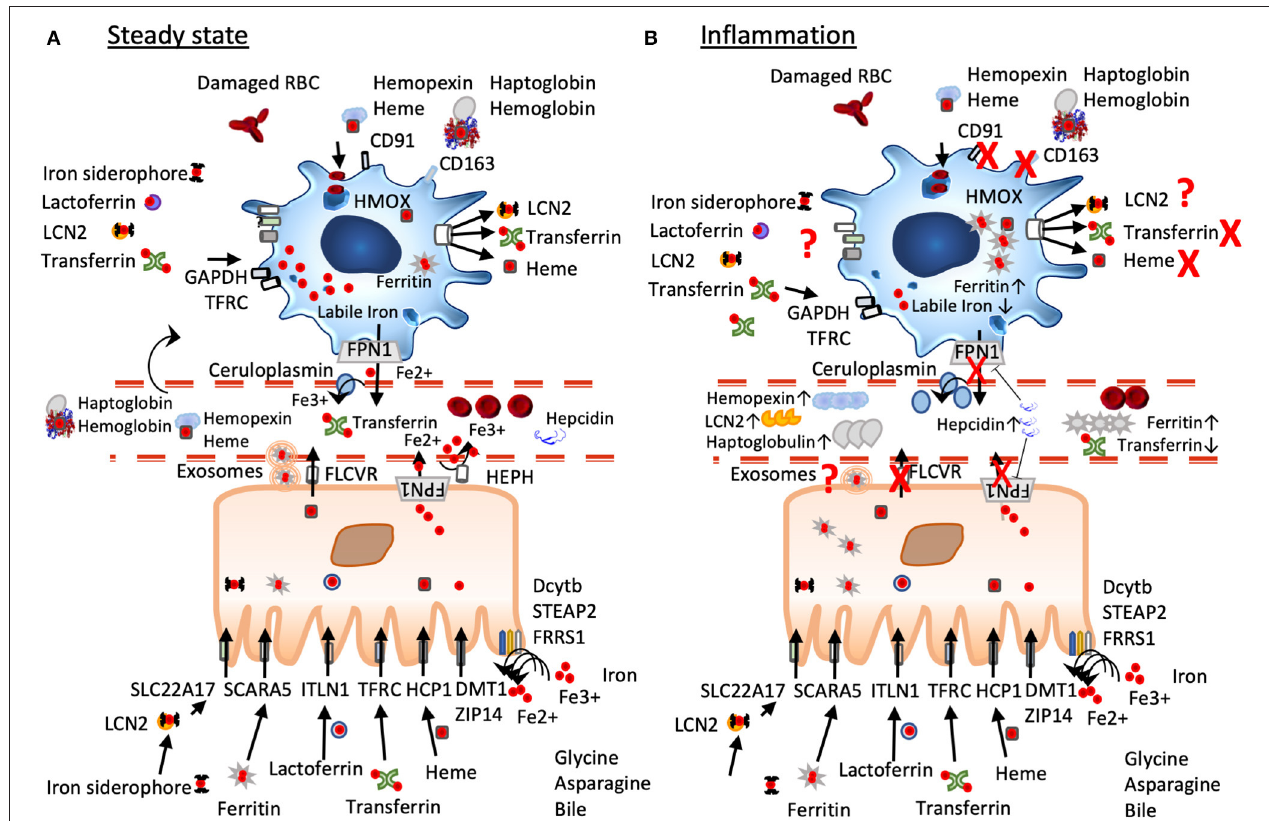
FIGURE 1 | A simplified scheme of iron homeostasis under steady-state and inflammatory conditions. (A) Under non-inflamed steady-state conditions, iron is reduced by ferric reductases (Dcytb, STEAP2, FRRS1) in the intestinal lumen to ferrous iron before import via DMT1 and ZIP14, heme iron is transported via the folate receptor HCP1, lactoferrin via ITLN1, dietary ferritin uptake occurs via SCARA 5, and chelated iron can be captured by LCN2 and transported by the enterocytes via SLC22A17. Cellular iron export occurs via ferroportin often aided by hephaestin and/or ceruloplasmin, ferritin seems to be exported via exosomal pathways, heme is exported via FLCVR. Macrophages under steady state have an anti-inflammatory phenotype characterized by a large labile iron pool, low ferritin-levels, and expression of iron importers such as CD163. They constantly take up but also export iron that derives from damaged red blood cells, from heme-hemopexin, haptoglobin-hemoglobin, LCN2, transferrin, and lactoferrin. (B) Under inflammation, iron mobilization is blocked due to increased expression of hepcidin that leads to FPN degradation and trapping iron inside the cells. Macrophages change to an inflammatory phenotype inhibiting iron import and export, their ferritin-levels are increased, while their labile iron pool is decreased. In the circulation levels of ferritin, hemopexin, haptoglobulin, and lipocalin 2 are elevated, while serum iron and transferrin are